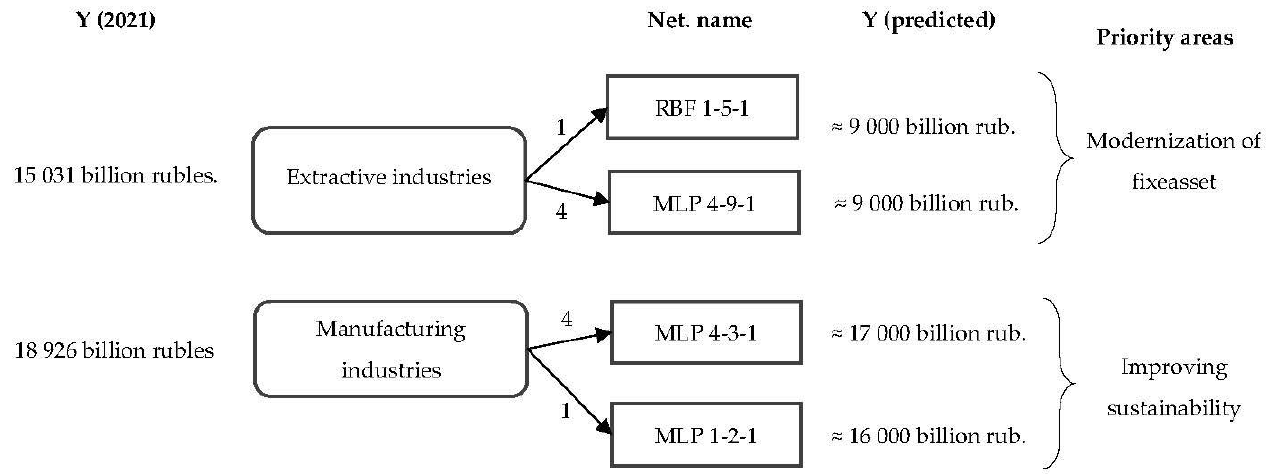
Figure 7. A predictive model for improving the efficiency of macro-industrial systems and priority areas for their development.